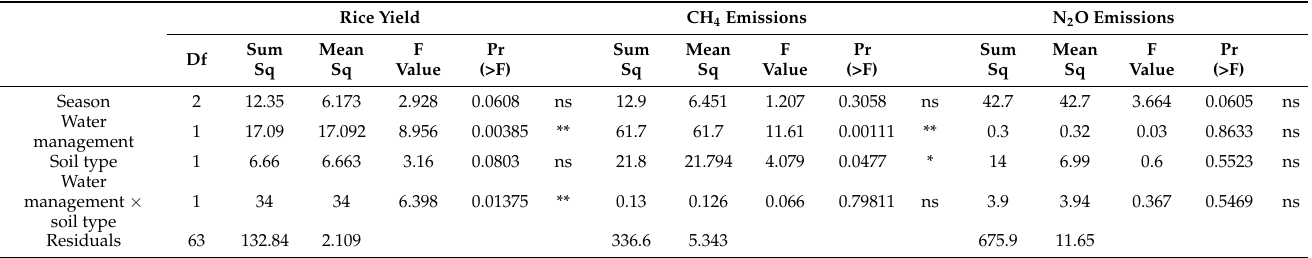
Table 3. Significant differences in the yield and methane emissions in the An Giang region over three rice cultivation